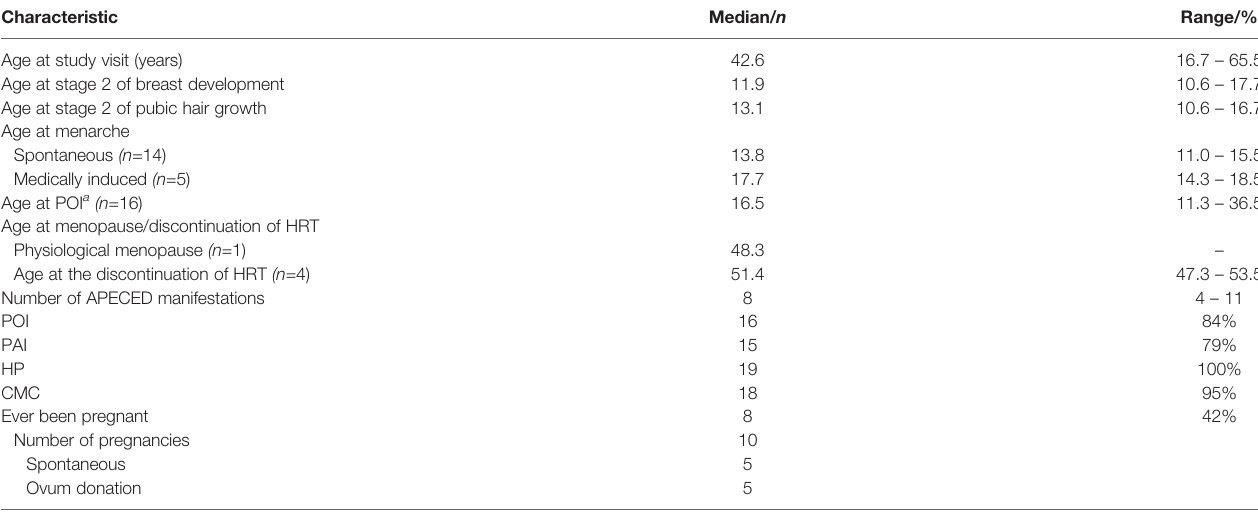
TABLE 1 | History of pubertal development, manifestations of APECED and pregnancies in the 19 patients with APECED.